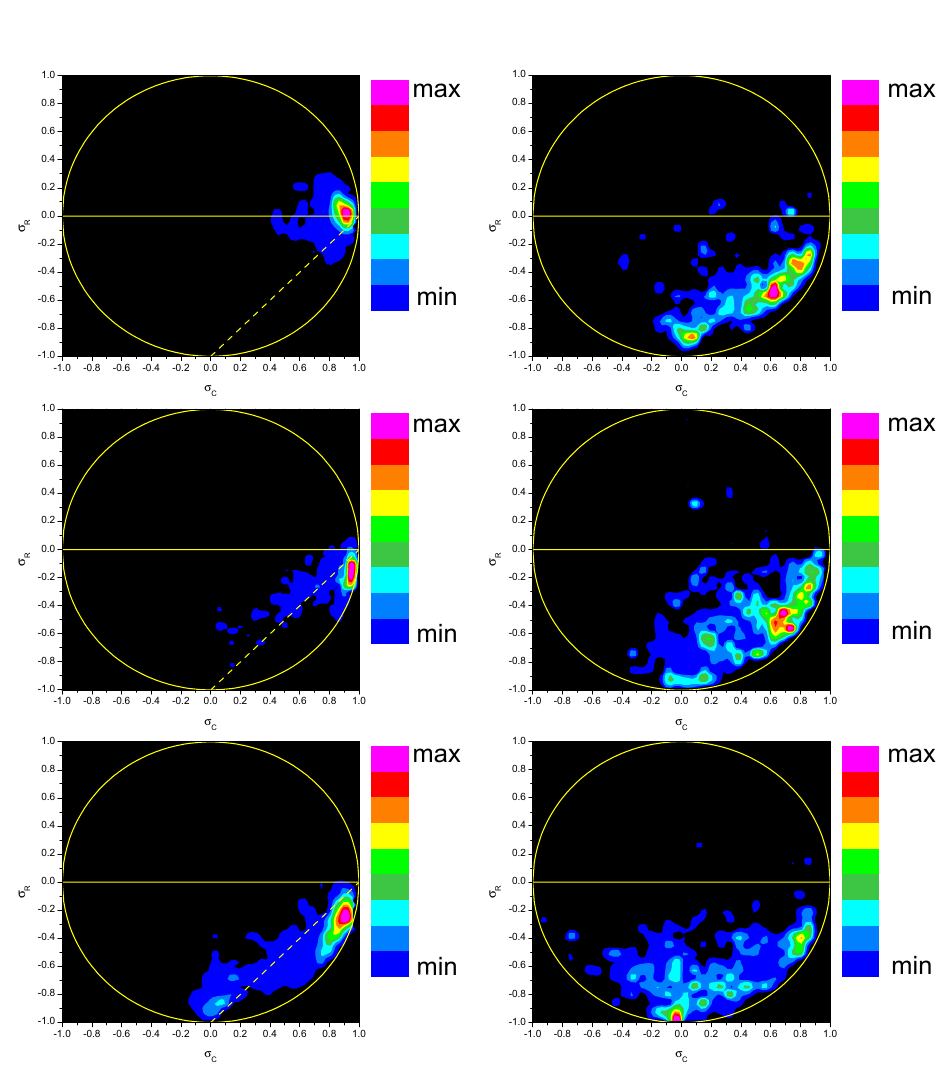
Figure 48: Left, from top to bottom: frequency histograms of 𝜎 r vs. 𝜎 c (here 𝜎 C and 𝜎 R ) for fast wind observed by Helios 2 at 0.29, 0.65 and 0.88 AU, respectively. The color code, for each panel, is normalized to the maximum of the distribution. The yellow circle represents the limiting value given by 𝜎 2 c + 𝜎 2 r = 1 while, the yellow dashed line represents the relation 𝜎 r = 𝜎 c − 1, see text for details. Right, from top to bottom: frequency histograms of 𝜎 r vs. 𝜎 c (here 𝜎 C and 𝜎 R ) for slow wind observed by Helios 2 at 0.32, 0.69 and 0.90 AU, respectively. The color code, for each panel, is normalized to the maximum of the distribution. Image reproduced by permission from Bruno et al. (2007), copyright